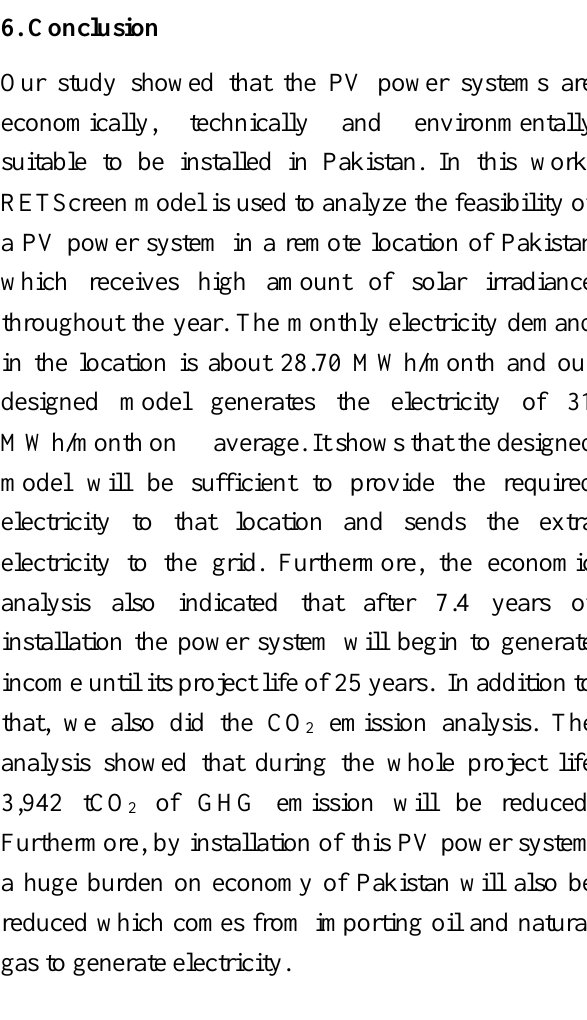
Fig. 10. Cash flow during project